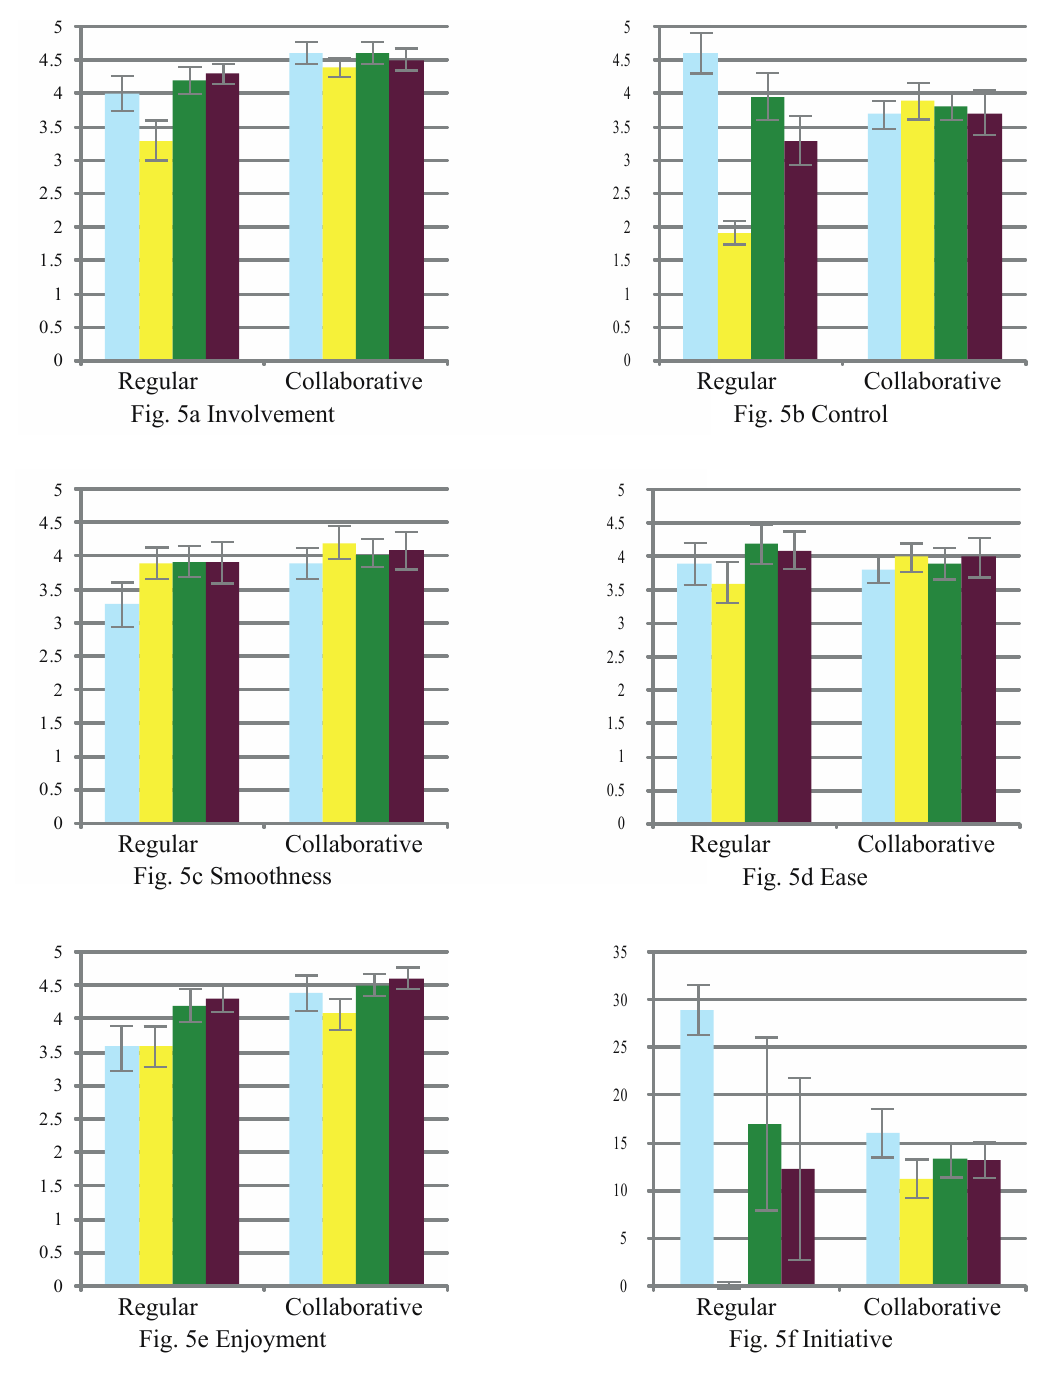
Fig. 5e Enjoyment Fig. 5f